Question: Looking at the figure, what chart type is it?
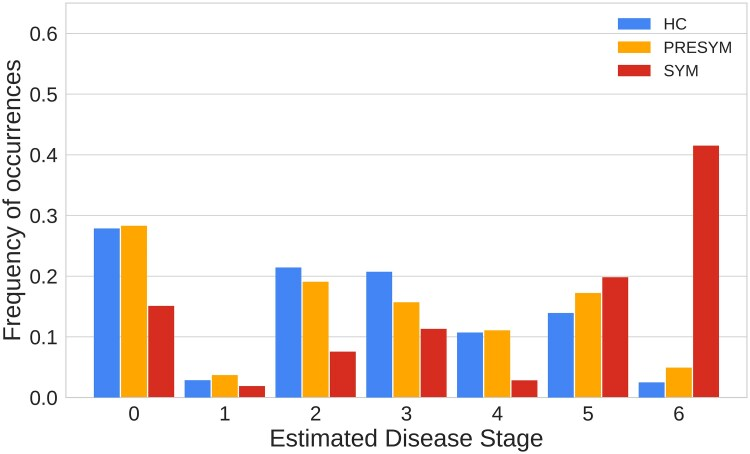
Answer: histogram